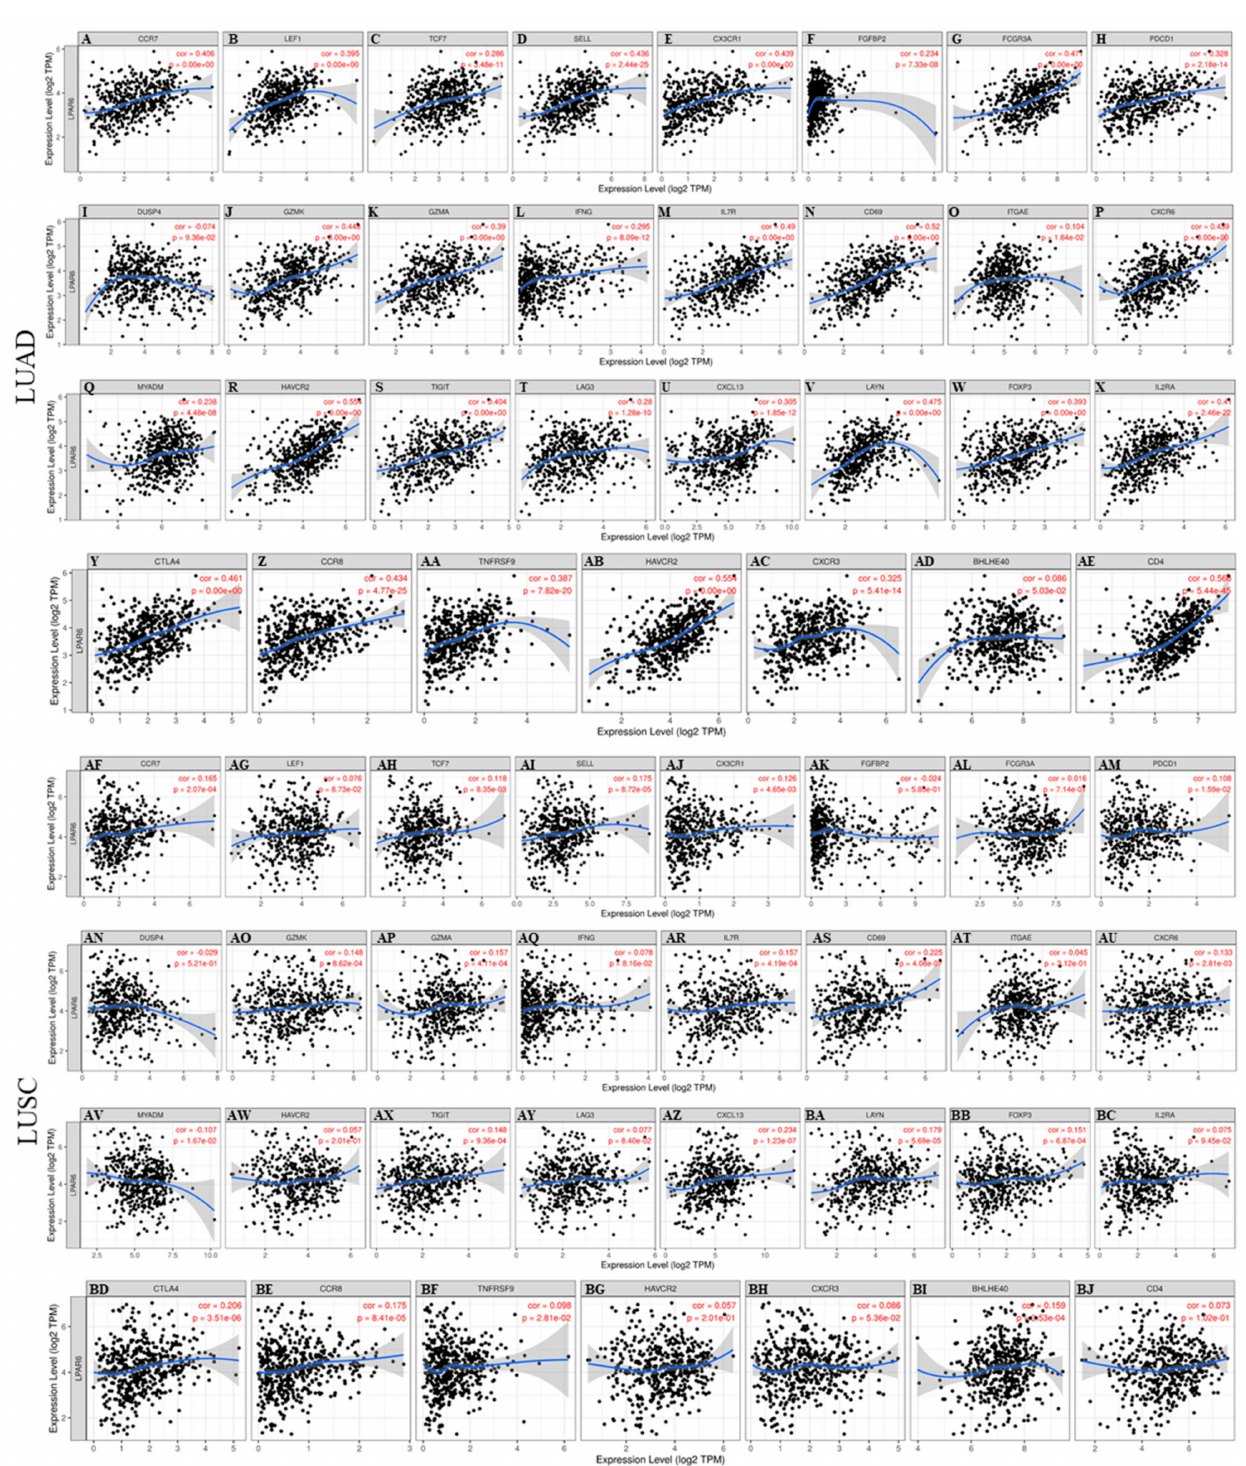
Figure 7. Correlation analysis between LPAR6 expression and various T cell marker sets in LUAD and LUSC. ( A – AE )